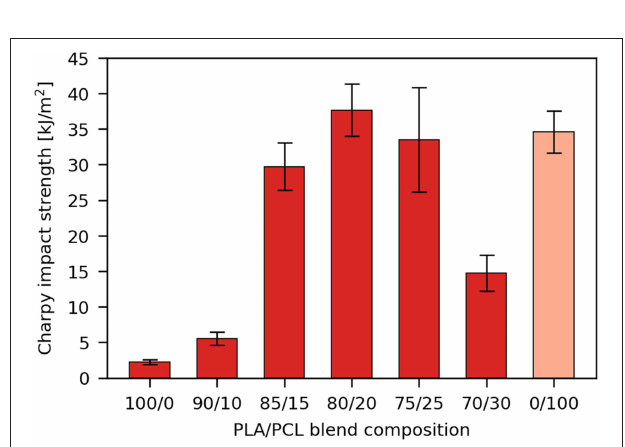
FIGURE 3 | Charpy notched impact strength of PLA/PCL blends as a function of their composition; error bars represent standard deviations. Adapted with permission from Ostafinska et al.